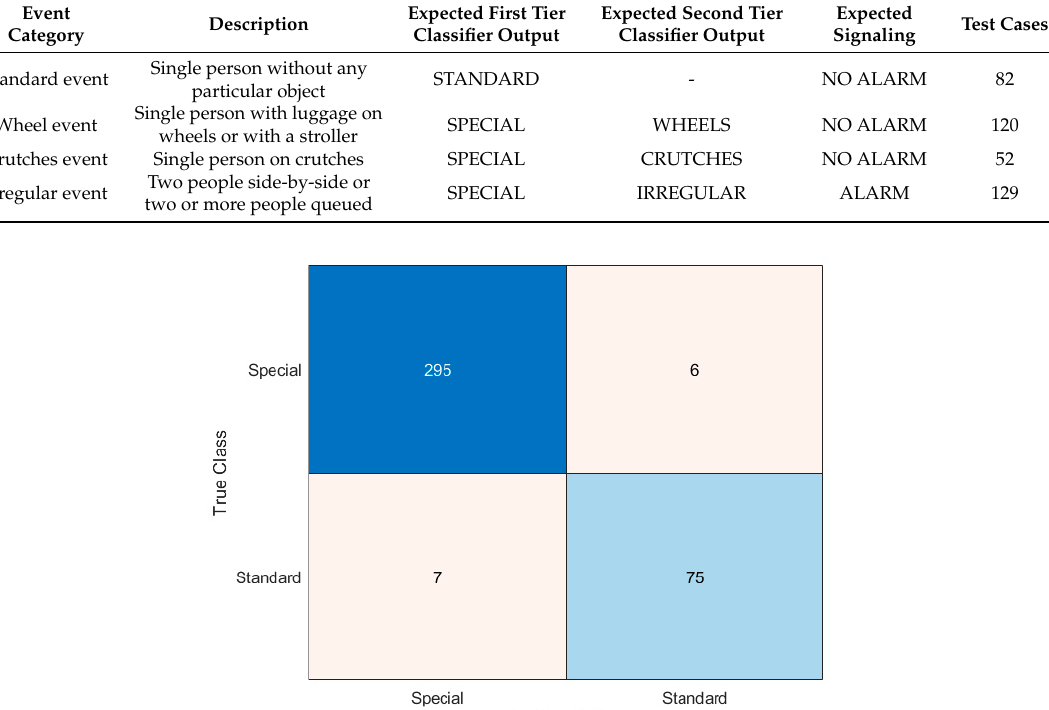
Table 1. Test cases and expected behavior of the classification algorithm.